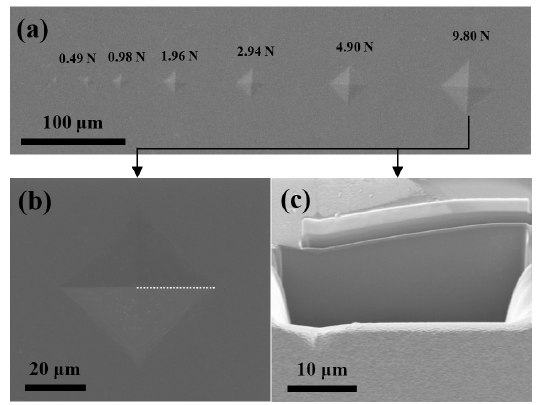
Figure 5. ( a ) Optical micrographs of Vickers indentations in the Ta 2 N coating at applied loads ranging from 0.49 to 9.80 N; ( b ) Plan view and ( c ) cross-sectional secondary electron FIB images of Vickers indentation under an indentation load of 9.80 N.